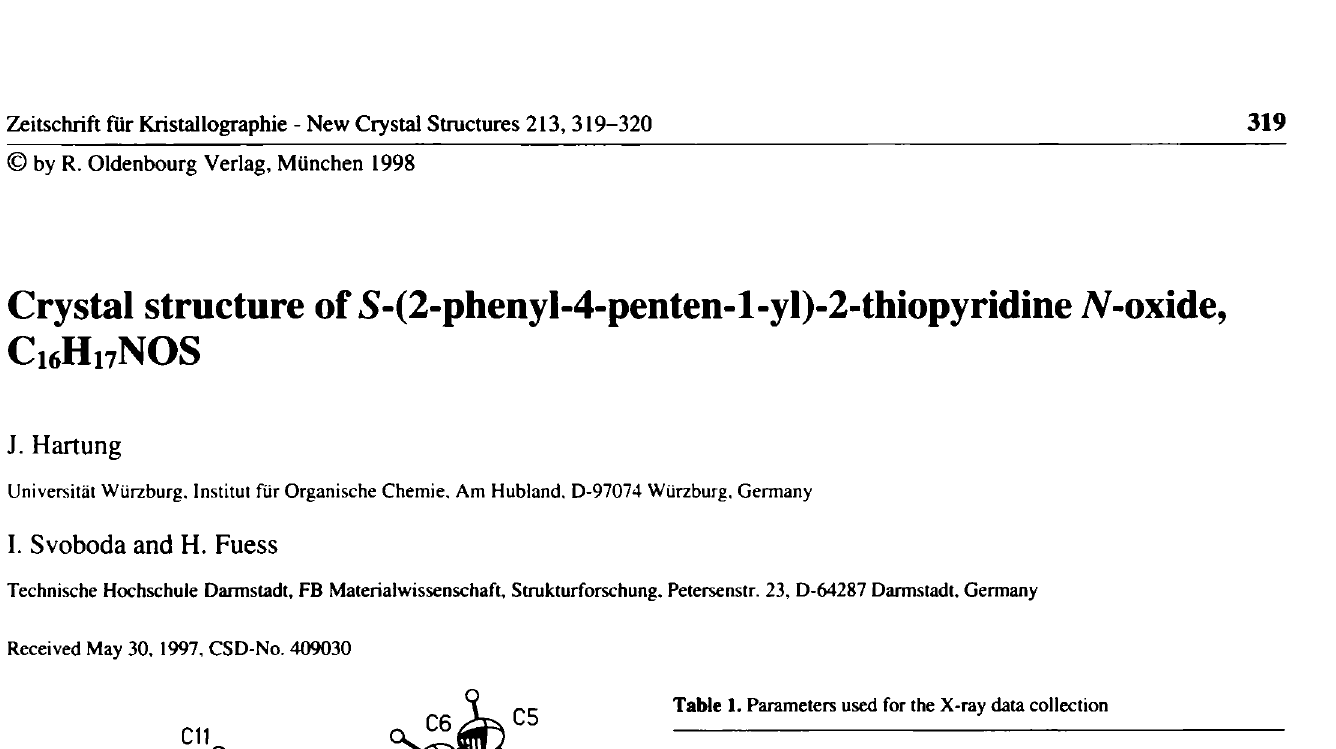
Table 2. Final atomic coordinates and displacement parameters (in